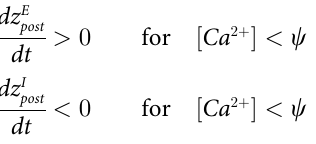
At the same time, inhibitory synapses can be lost by the retraction of inhibitory dendritic ele- ments. This suggests that new excitatory post-synaptic elements should be formed and inhibi- tory ones removed when neuronal activity is less than its optimal level (([ Ca 2+ ] < ψ ) in Fig